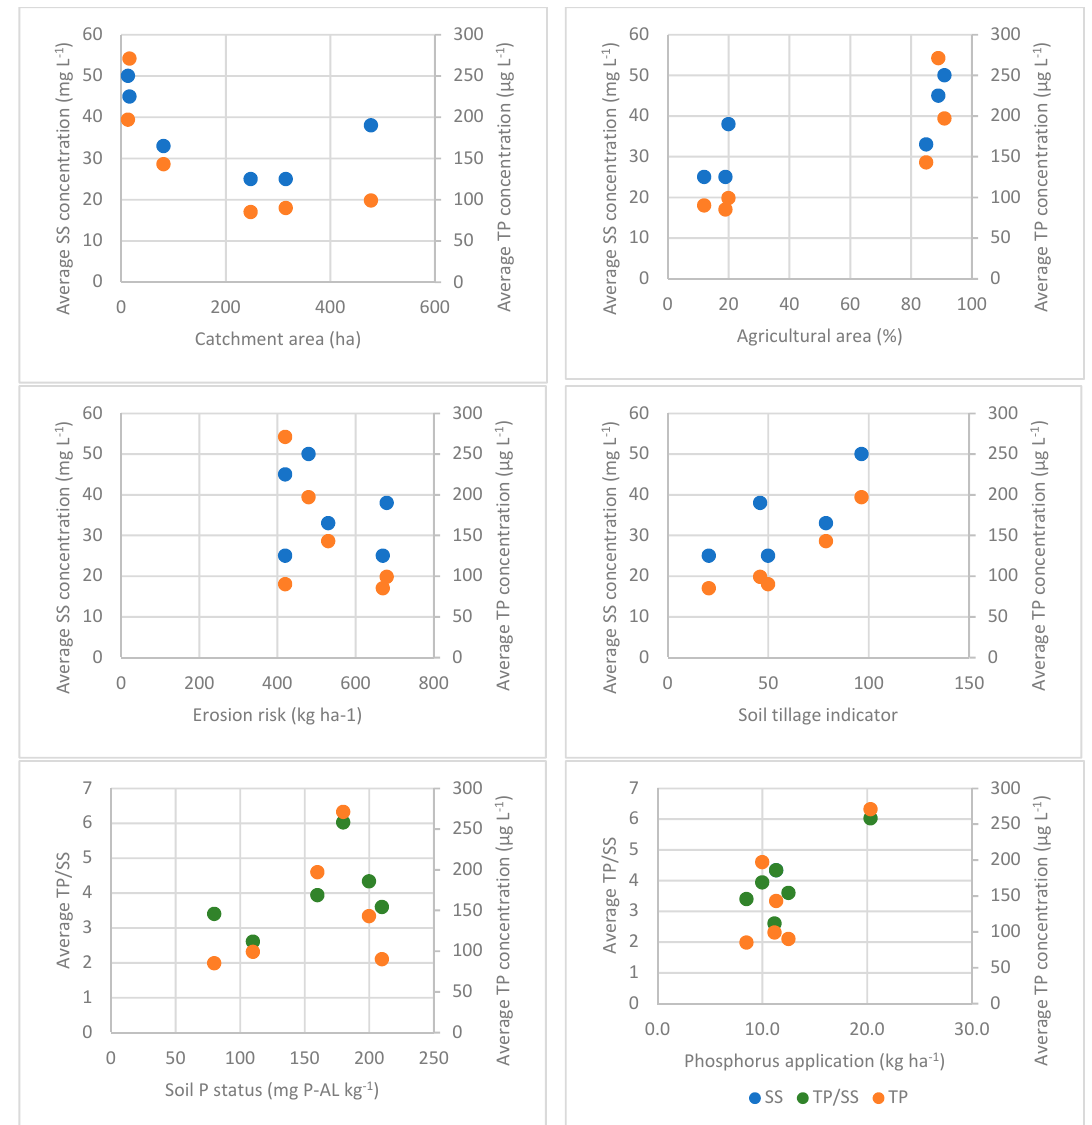
Figure 7. Fixed catchment specific effects of catchment area (ha), agricultural area (%), erosion risk (kg ha − 1 ) and soil tillage indicator on average concentrations of suspended sediments (mg L − 1 ) and total phosphorus (µg L − 1 ), and effect of soil P status (mg kg − 1 ) and phosphorus application rate on concentrations of total phosphorus (µg L − 1 ) and TP/SS.